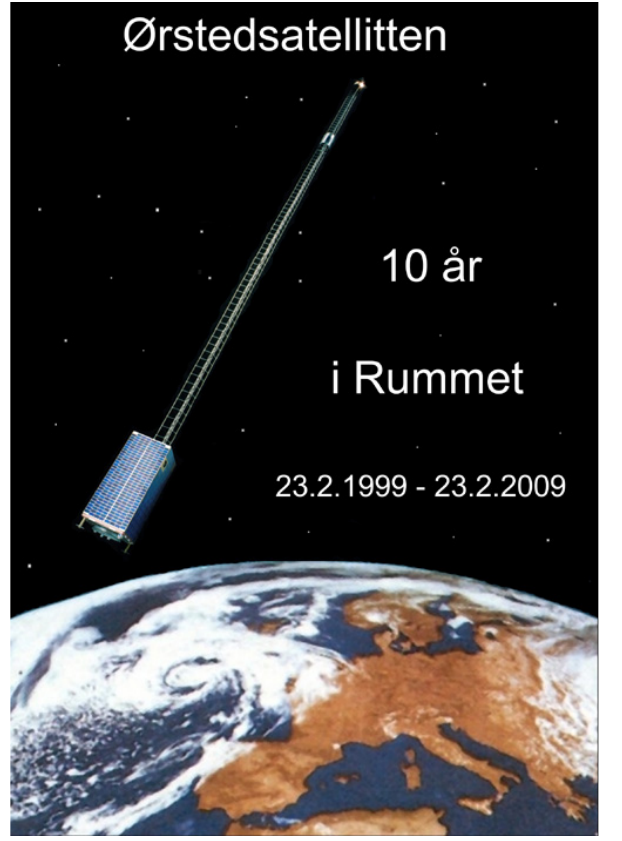
Figure 26. Celebration of Ørsted’s 10 years in Space on 23 Febru- ary